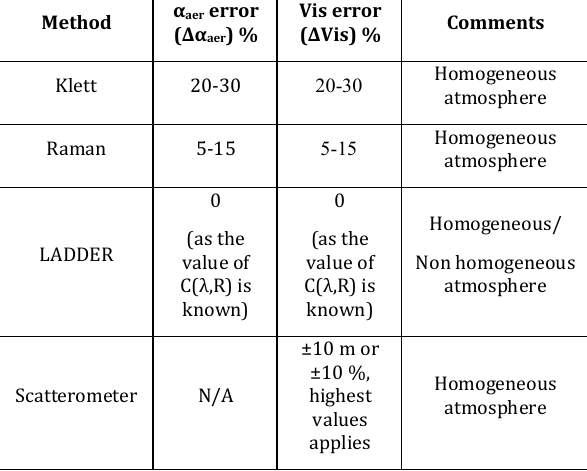
Table 1. Various methods and techniques used to derive/estimate the atmospheric extinction and/or visibility and their associated uncertainty, compared to the LADDER technique in homogeneous/non homogeneous atmospheres [1].